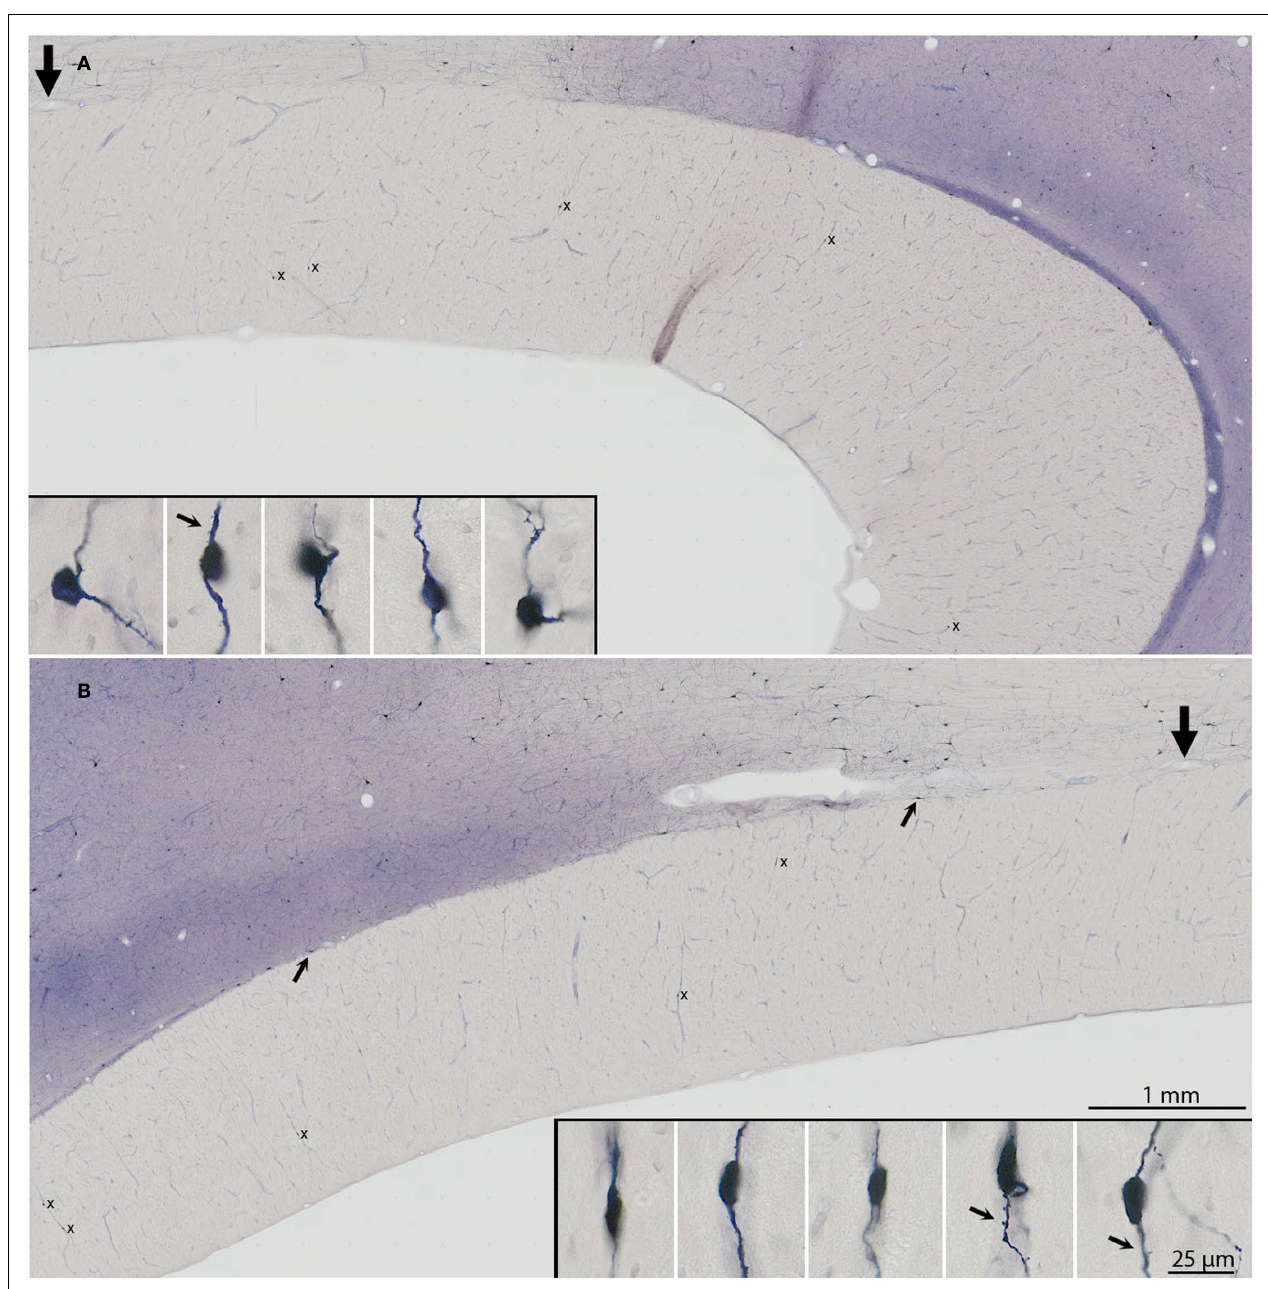
arranged from anterior (at right) to posterior (at left), and the lower five, similarly, for the segment shown in (B) . Arrows in three of the insets point to sparsely distributed dendritic spines. Neurons have been rotated so that the major axis is perpendicular to the dorsal surface of the brain. NADPHd + neurons are also obvious at the dorsal margin of the callosum [two small arrows in (B) ] and in the overlying cortical white